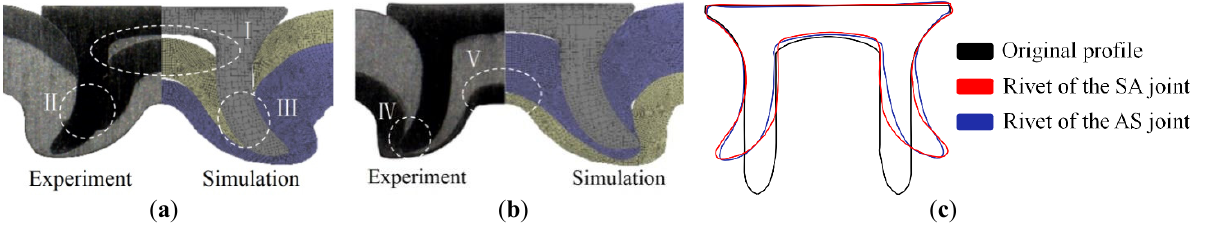
Figure 5. Section profile comparison. ( a ) Experiment section and simulation section of the SA joint; ( b ) experiment section and simulation section of the AS joint; ( c ) original profile and deformed pro- files of rivets.